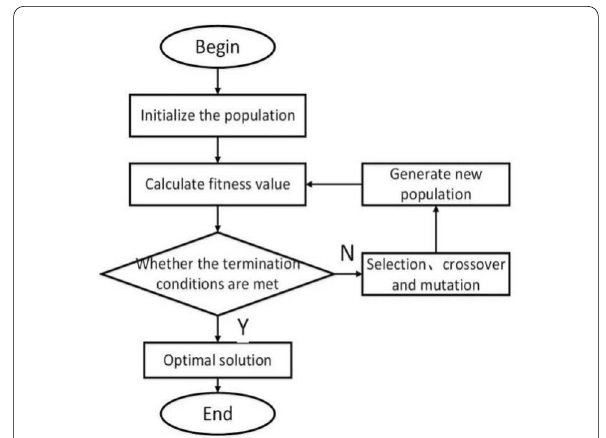
Figure 2 Genetic algorithm